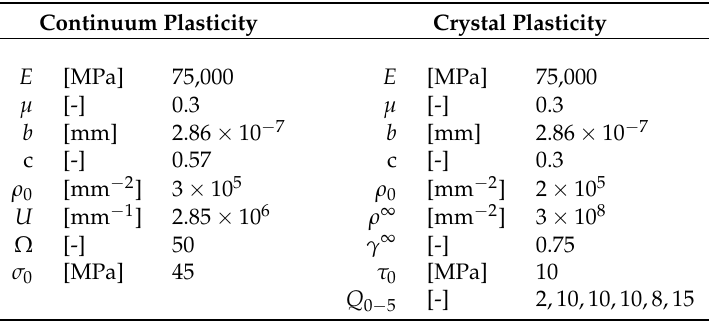
Table 1. Material data used in